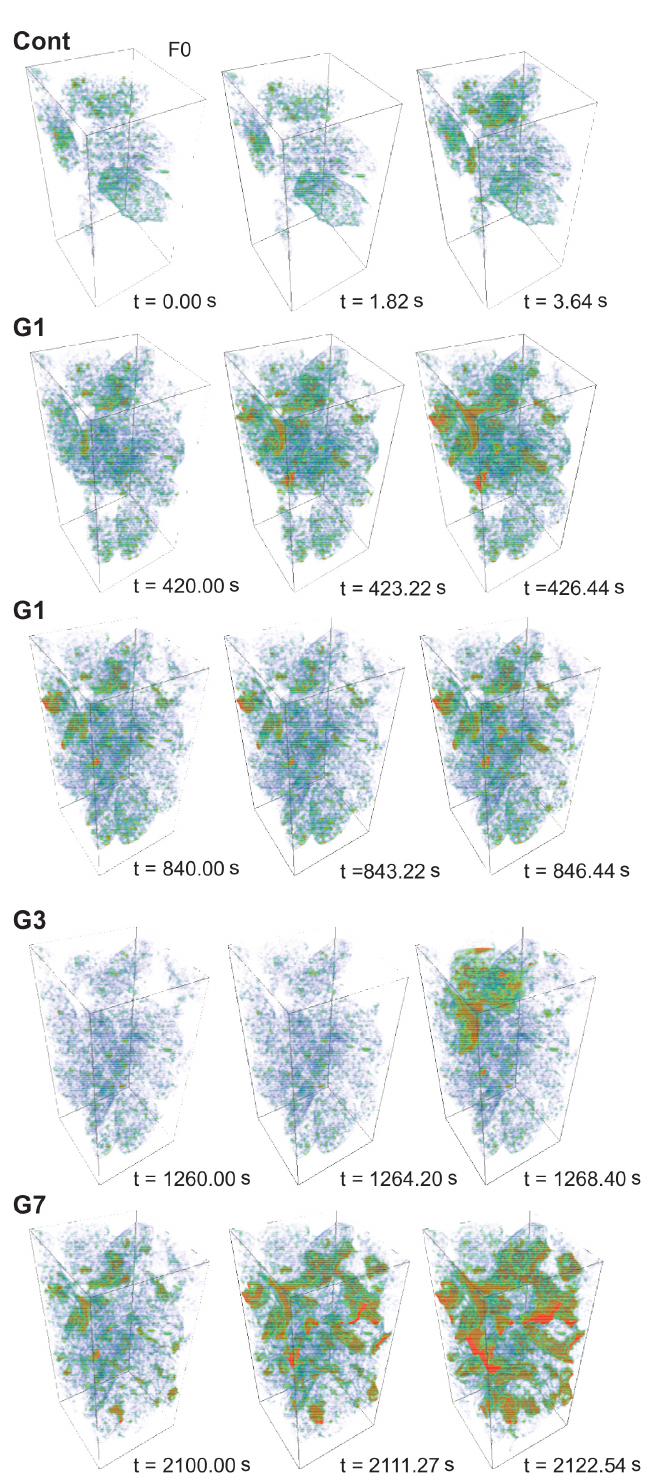
Figure 6. Three-dimensional renders of a gapped experimental run. For each scan series the first, middle, and last frame of each acquisition period is shown. Only the fluid volume has been rendered, with the colour representing the distance to the fluid interface. Cool colours rep- resent small fluid volumes; warm colours represent fluid more than 20µm from the interface. The field of view is 1.5mm × 1.5mm × 3mm. Data from sample LD_1, scans 1 to